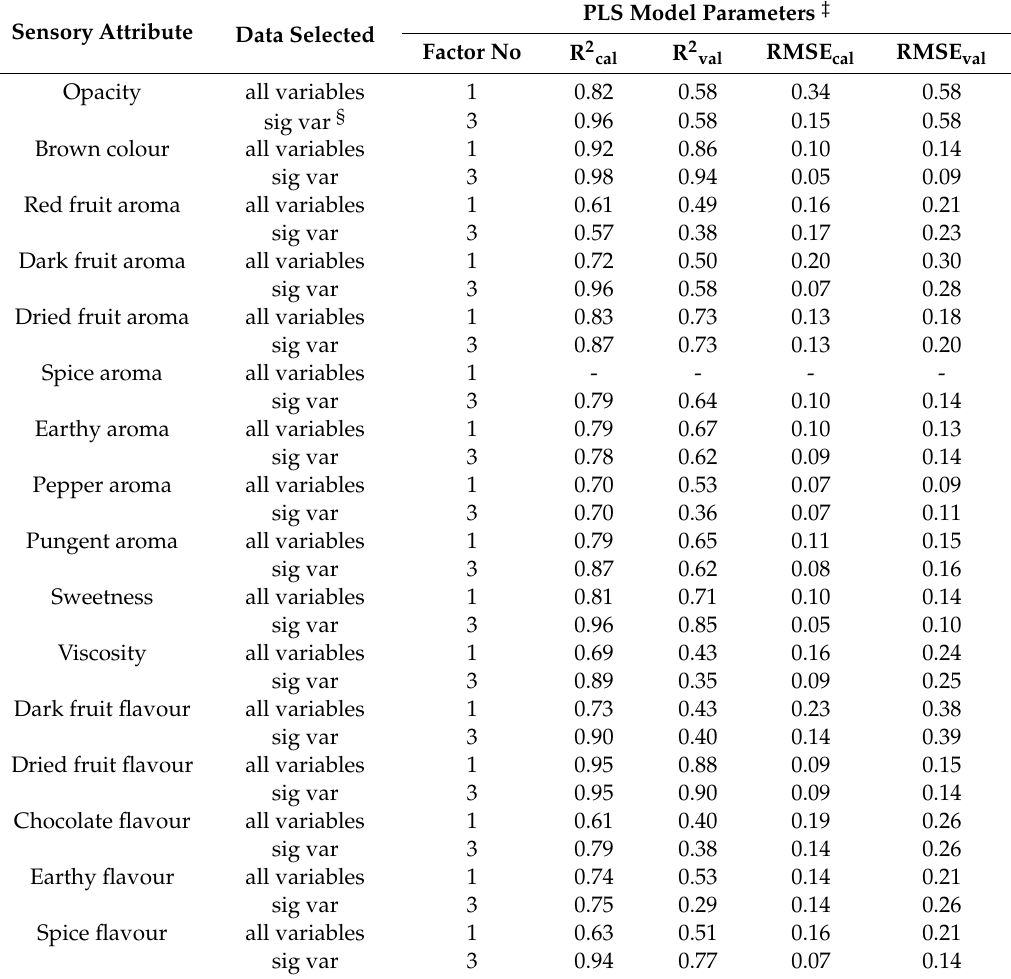
Table 4. Partial least squares (PLS) regression analysis for the prediction of well-modelled wine sensory variables from wine chemical data, excluding amino acid analysis †